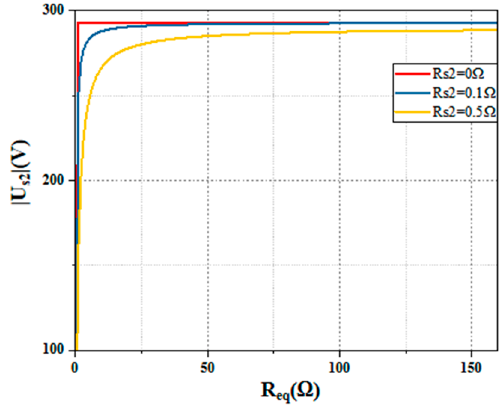
Figure 16. Equivalent S-LCL compensation topology.